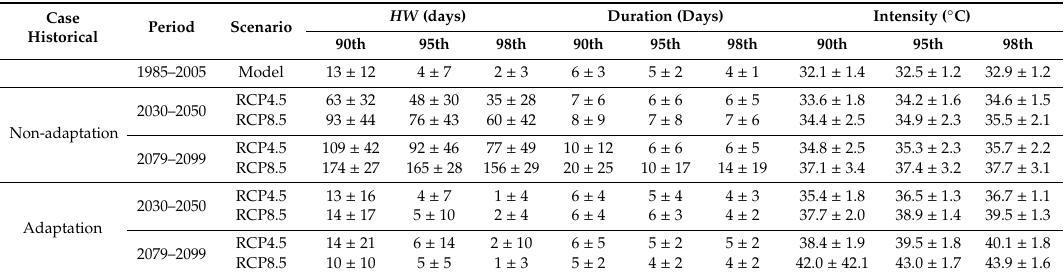
Table 1. Average annual characteristics of heat waves in the MRSP. (RCP: Representative Concentration Paths).